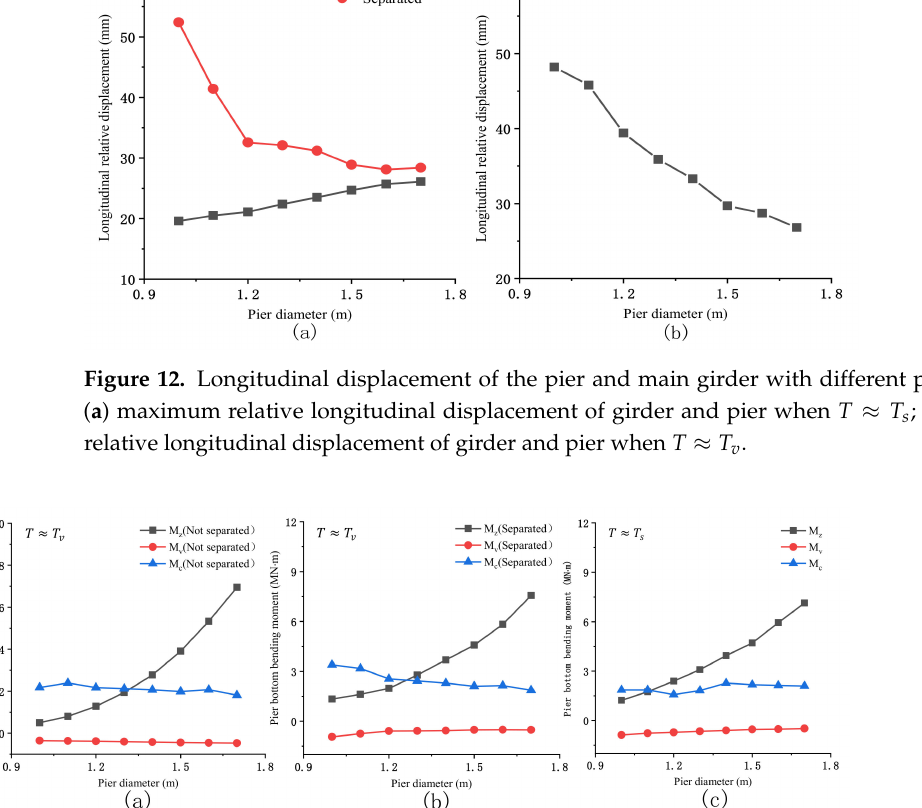
Figure 13. Bending moment at the base of the pier with different pier diameters: ( a ) the value of bending moments when separation was ignored at T ≈ T s ; ( b ) the value of bending moments when separation was considered at T ≈ T s ; and ( c ) the value of bending moments at T ≈ T v .